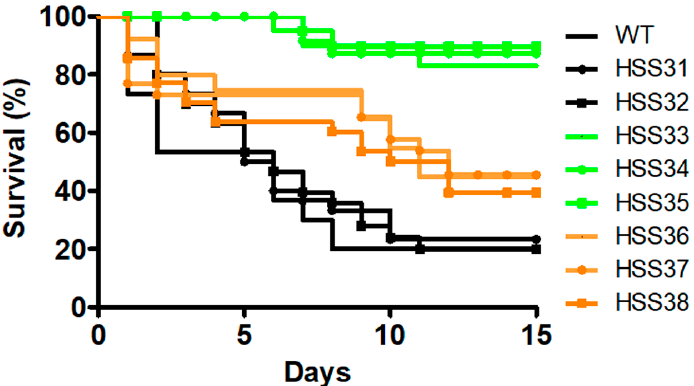
Figure 7. Galleria mellonella killing curves by Sporothrix schenckii wild-type, control, and ROT2 -silenced strains. Animal groups contained 30 larvae and were inoculated with 1 × 10 5 yeast-like cells of the different strains, and survival was recorded daily for two weeks. Data are shown in Kaplan–Meier plots. The statistical analysis showed no differences among the WT, HSS31, and HSS32 strains ( p = 0.57), among HSS33, HSS34, and HSS35 ( p = 0.88), or among HSS36, HSS37, and HSS38 ( p = 0.79). However, the two groups of silenced strains showed curves statistically different when compared between them or with the control group (in black lines; p < 0.05, for both